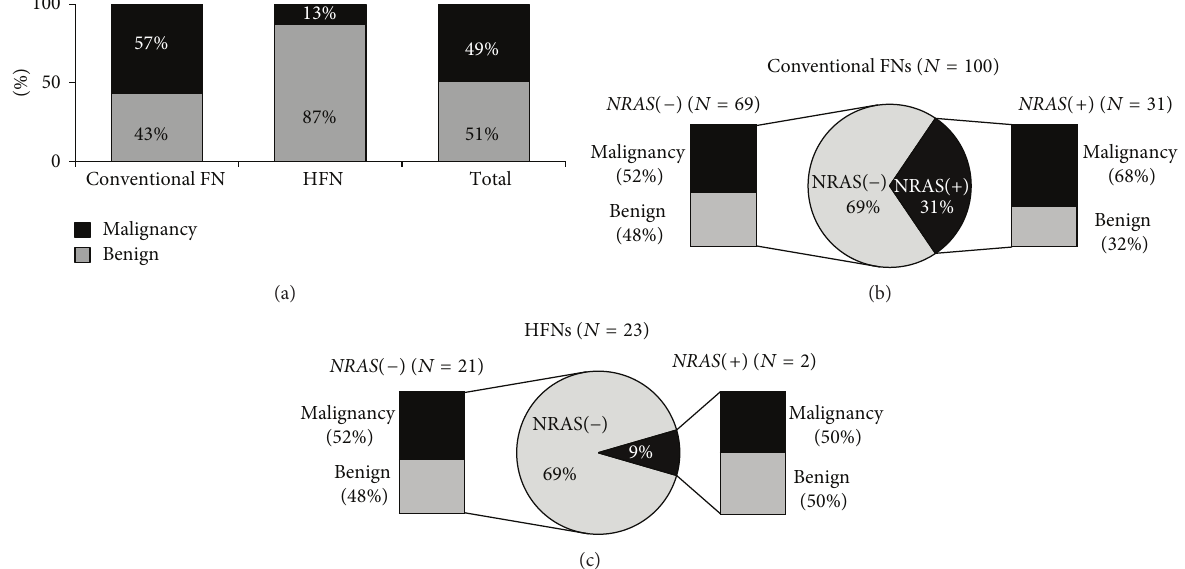
Figure 1: (a) Postoperative surgical pathology results of 123 thyroid nodules with a preoperative diagnosis of follicular neoplasm (FN) according to the histological subtypes. (b) Surgical results and NRAS mutation status of the 100 conventional FNs. (c) Surgical results and NRAS mutation status of the 23 H¨urthle cell neoplasms